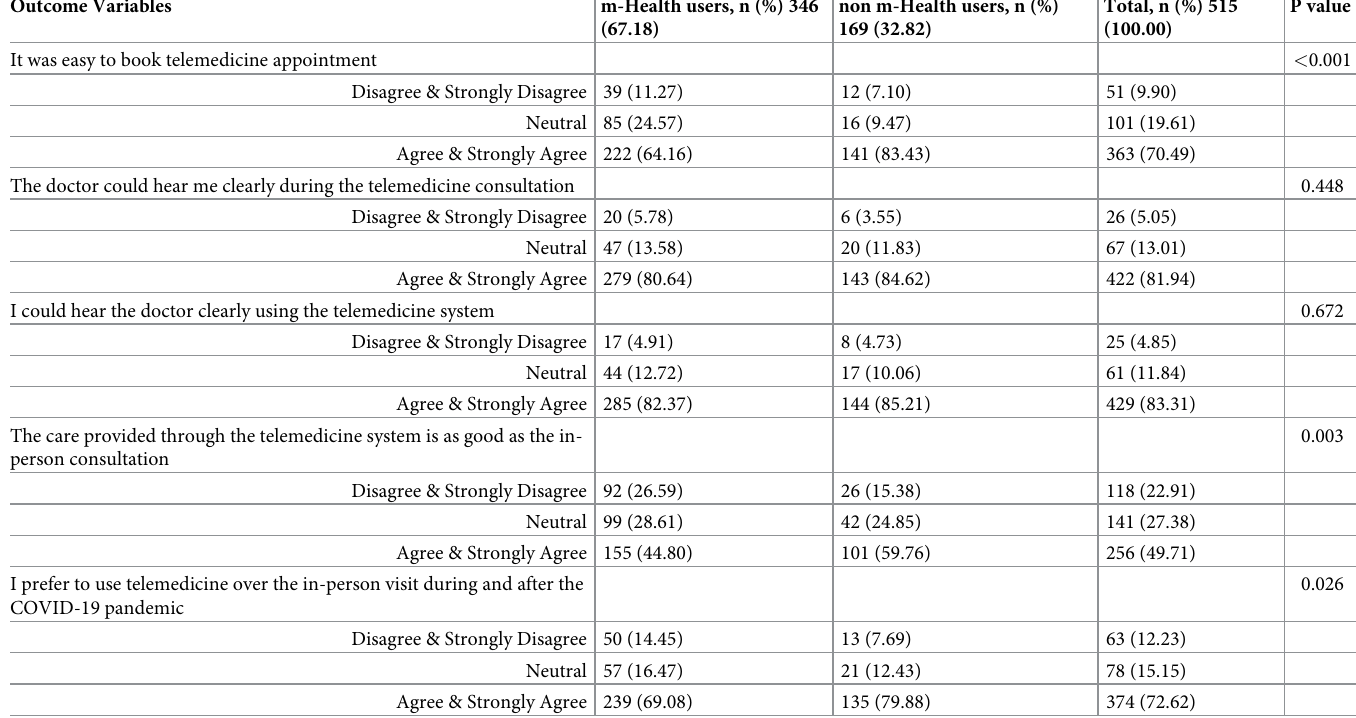
Table 2. Comparison of survey responses on the perceived usefulness and ease of use of telemedicine services provided by mobile application users versus non- users. Outcome